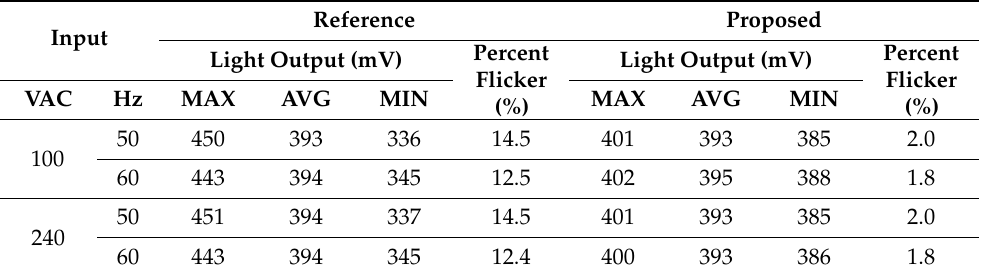
Table 3. Comparison of percent flicker.